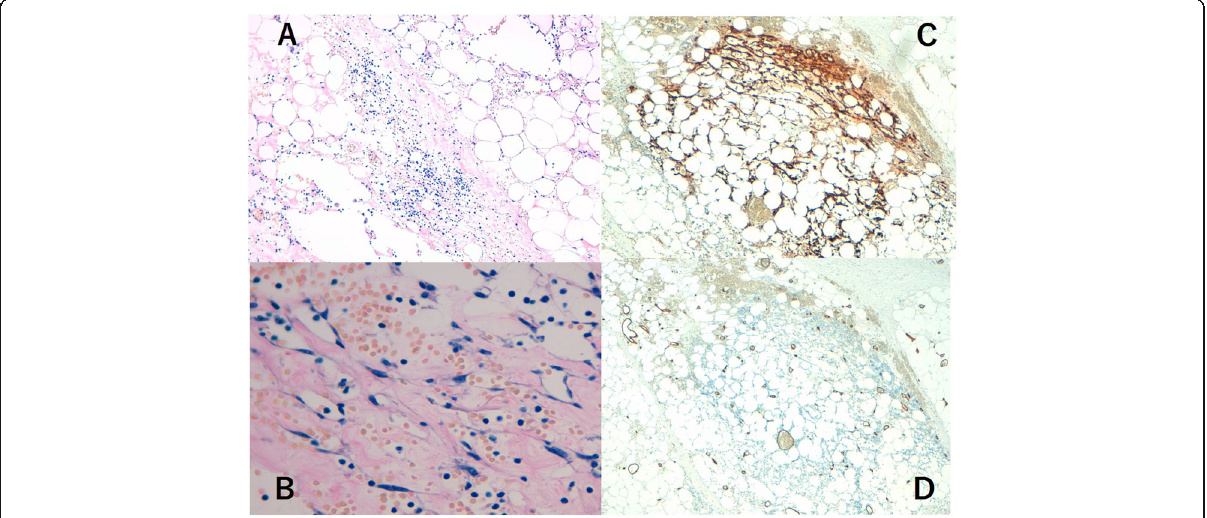
Fig. 3 a Hematoxylin and eosin staining. There were many spindle cells and dilated vascular channels. b Magnification of hematoxylin and eosin staining. Immunostaining of the tumor was CD31-positive ( c ) and mildly positive for CD34 ( d